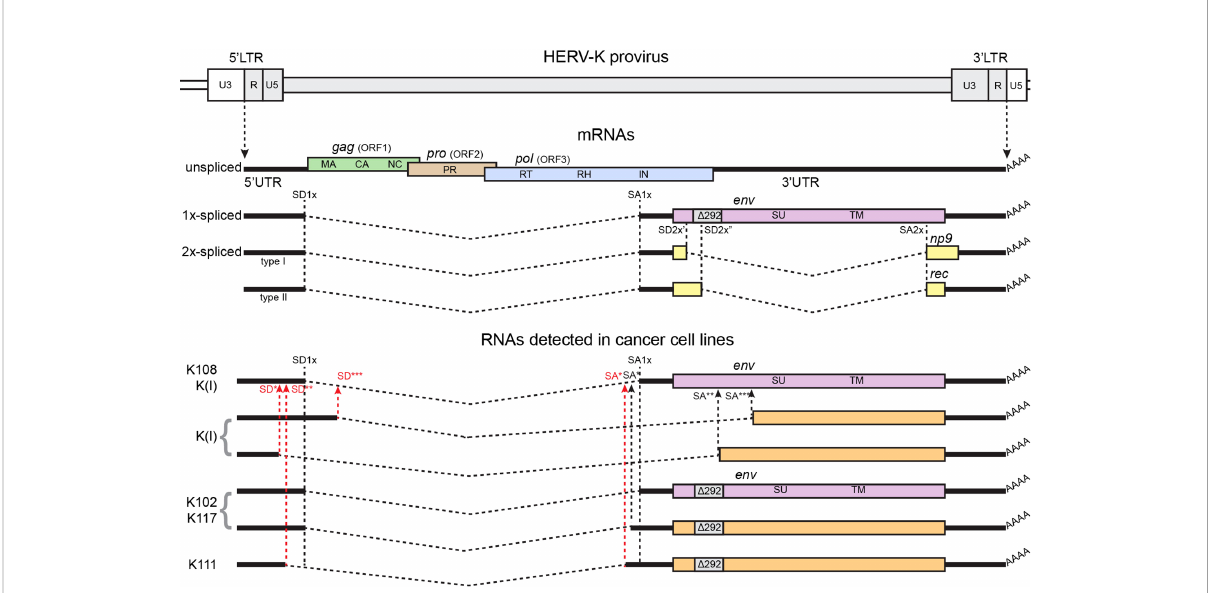
FIGURE 2 Structure of the HERV-K genome, canonical spliced mRNAs, and spliced RNAs detected in (28), from which the fi gure was adapted. A genetic map of a HERV-K provirus (gray) inserted into fl anking host genome sequences is shown. The unspliced primary viral transcript, singly spliced env mRNA, and doubly spliced rec and np9 mRNAs are shown below the viral genome. Poly (A) tails are indicated (AAAA). The 292 nucleotide deletion of type 1 HERV-K proviruses spanning the pol-env junction is indicated ( D 292). The dashed, angled line shows the excised intronic sequences. Colored boxes indicated the different genes, indicated in the fi gure by name and ORF. Splice donor (SD) and splice acceptor (SA) sites are indicated on map, including canonical sites for 1x-spliced mRNA (SD1x and SA1x) and canonical sites for 2x-spliced mRNAs (SD2x ’ for type I proviruses, SD2x ” for type II proviruses, and SA2x), and individual alternative SD/SA are identi fi ed by stars (*, **, and ***) and are written in red in case of aberrant sites, without canonical sequences for spliceosomes. Black vertical dashed lines identify canonical SD/SA sites across the panel, black arrows show alternative SD/SA sites, and red arrows show SD/SA aberrant sites. HERV-K108, HERV-K(I), HERV-K102, HERV-K117, and HERV-K111 are the names of individual HERV-Ks detected in the